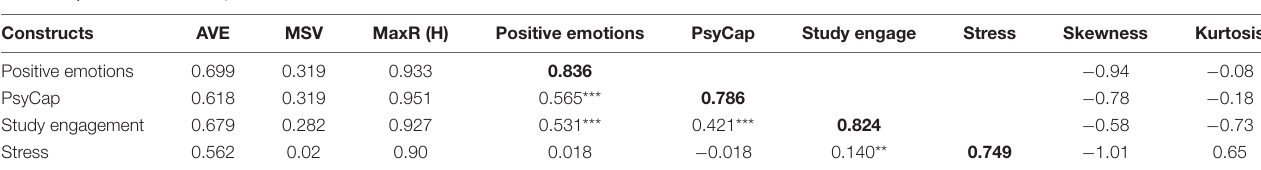
TABLE 1 | Discriminant validity.